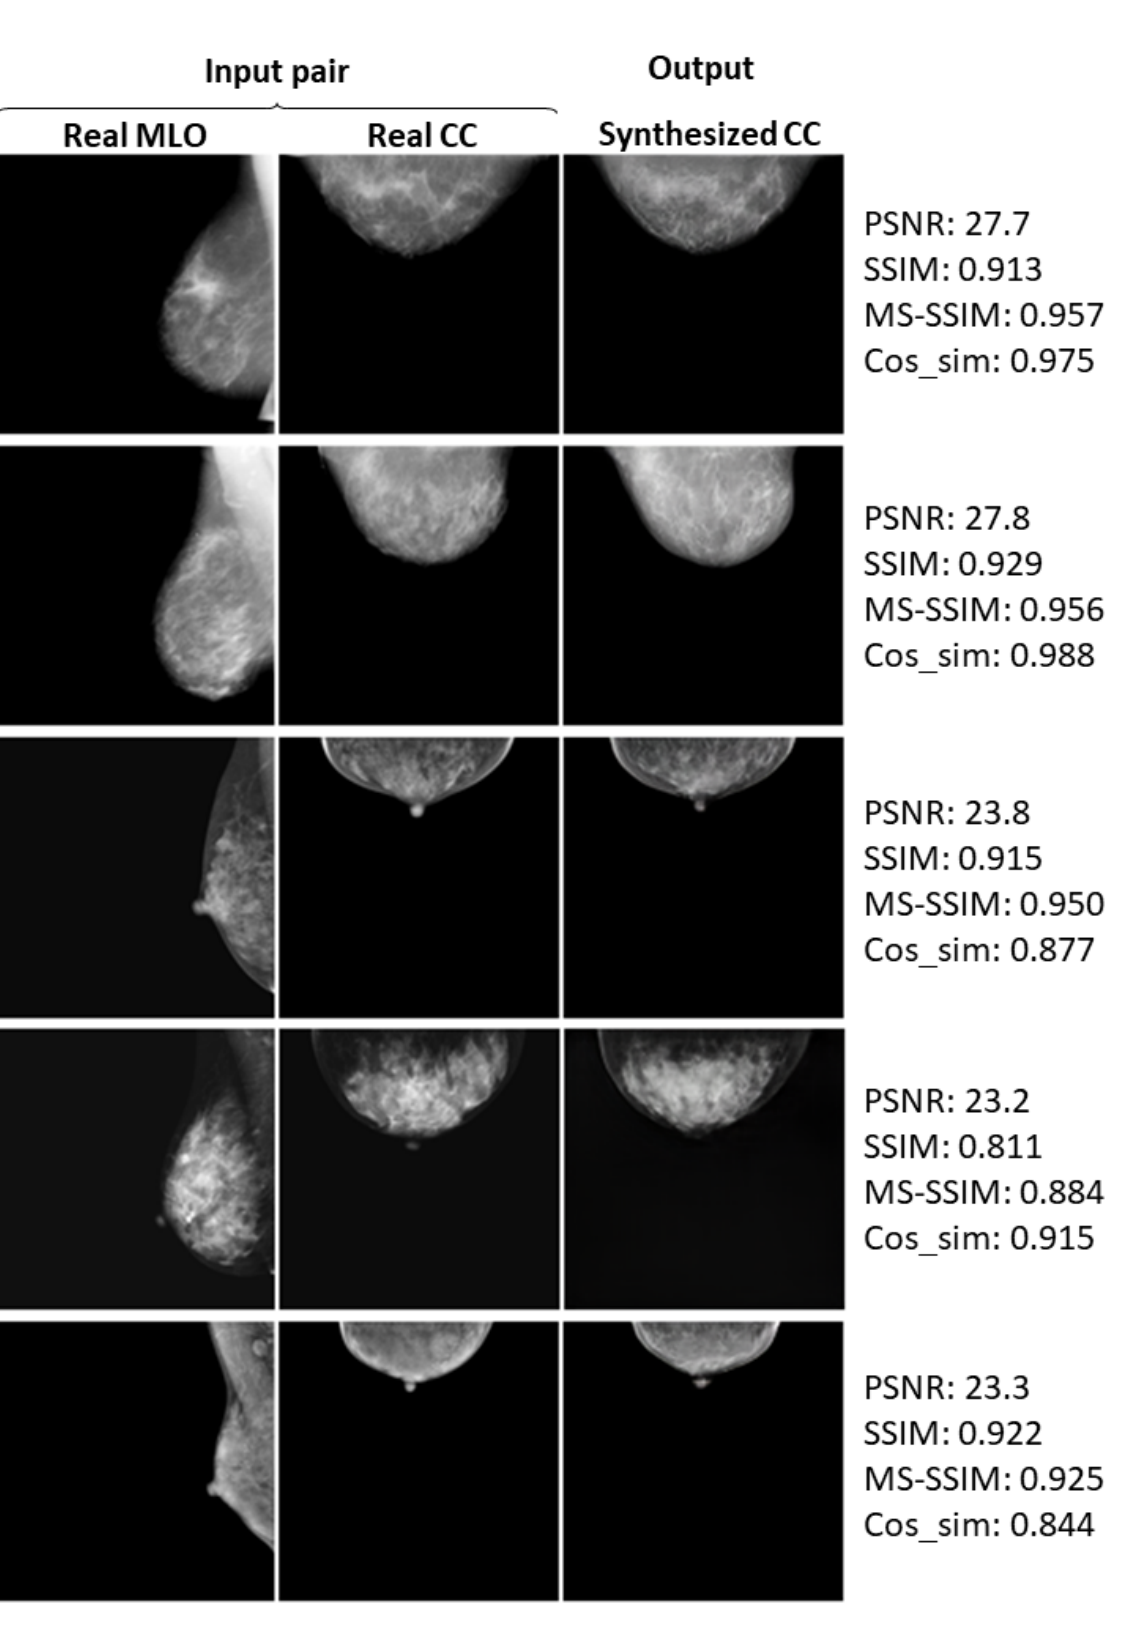
Figure A1. Real and synthesized CC-view mammograms at 128 × 128 resolution: further